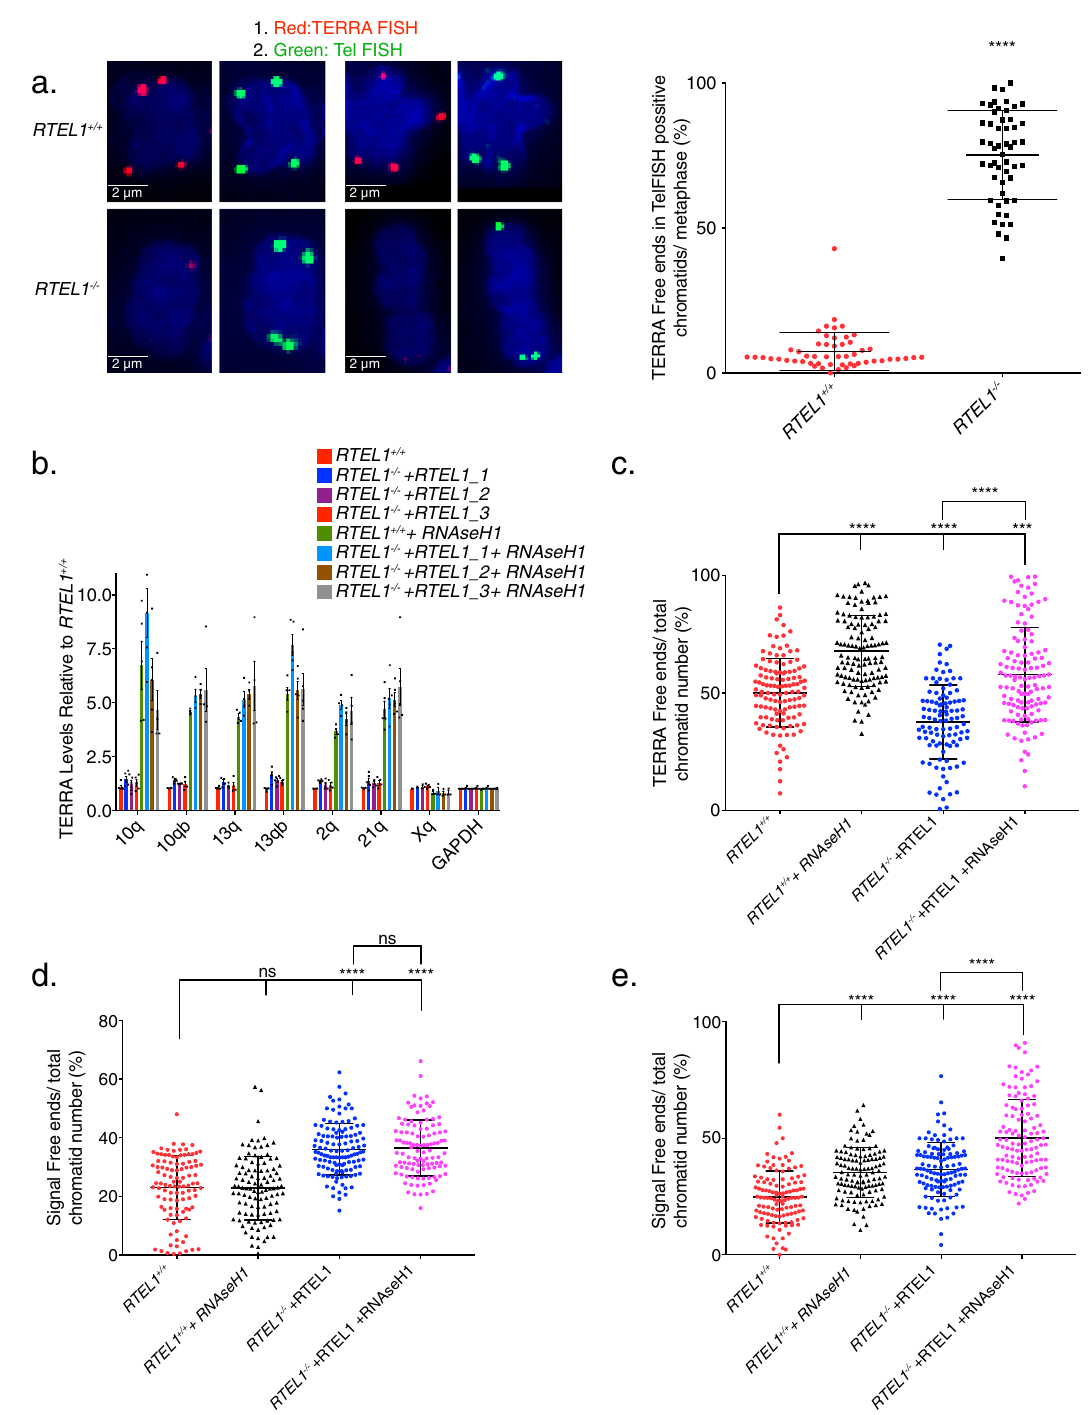
Fig. 5 RNAse H1 overexpression partially phenocopies RTEL1 de fi ciency. a Example chromosomes, and quantitation of TERRA free ends per chromatid in Tel FISH-positive chromatid ends. Samples were processed by sequential TERRA-Tel FISH and scored for TERRA (red) in telomeres marked by Tel FISH signal (green). Chromatid ends in at least 25 metaphases in two experiments were counted (**** p < 0.0001, two-sided t -test). TERRA levels are elevated after RNAse H1 overexpression. b TERRA levels of speci fi ed chromosome ends were tested in cells transfected with RNAse H1-GFP . Bars represent the relative TERRA expression measured by qRT-PCR in three independent experiments p -values are listed in Supplementary Fig. 10B (* p < 0.05, ** p < 0.01, *** p < 0.001, **** p < 0.0001, two-sided t -test). Means and standard deviation is shown. c Quanti fi cation of TERRA loss per chromatid in cells transfected with RNAse H1-GFP by TERRA FISH (22 days in selection). d Quanti fi cation of telomere loss per chromatid in cells transfected with RNAse H1-GFP by telomere FISH (22 days in selection). e Quanti fi cation of telomere loss per chromatid in cells transfected with RNAse H1-GFP by telomere FISH (52 days in selection). Three independent cell lines complemented with RTEL1 were averaged for analysis where speci fi ed. FISH experiments represent the average of at least 50 metaphases in each of 2 independent experiments and three independent reconstitutions shown as the mean and standard deviation (* p < 0.05, ** p < 0.01, *** p < 0.001, **** p < 0.0001, two-sided t -test) (see also Supplementary Fig.